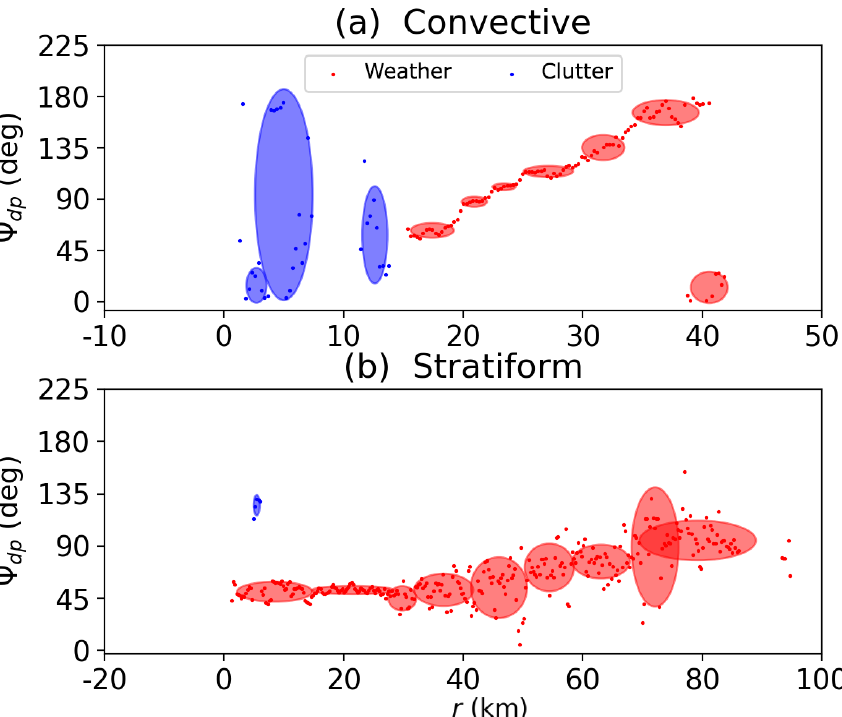
Figure 3. Examples of data masking: (a) a convective case (azimuth 252 ◦ ) and (b) a stratiform case (azimuth 1 ◦ ). The blue points and ellipses represent the clutter data and clusters, respectively, while the red color corresponds to the weather echoes. The x axis is the radar range in